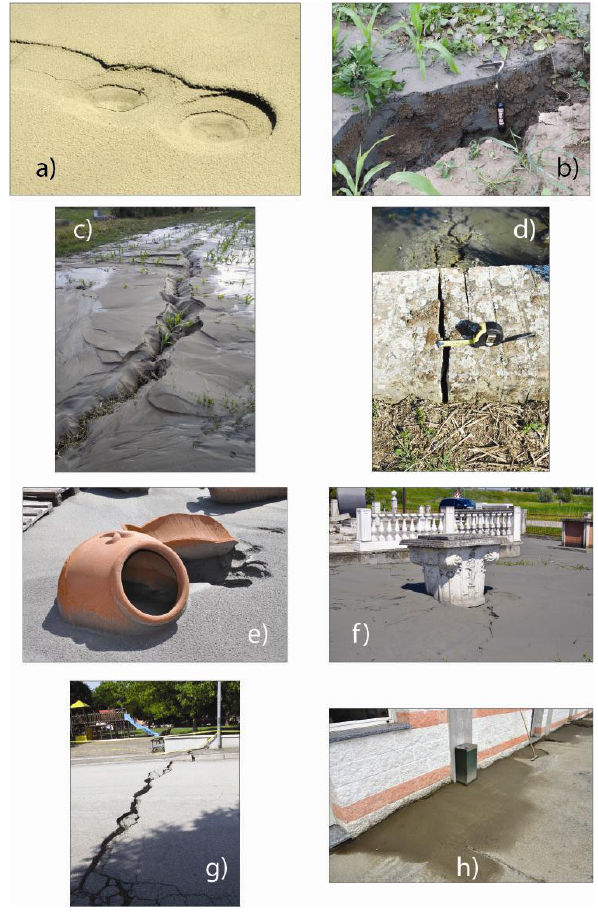
635 Figure 3: Examples of liquefaction produced by the 2012 Emilia sequence on the ground 636 Fig. 3. Examples of surface phenomena produced by the 2012 and on manmade structures: a) detail of aligned multiple sand blows nearby 637 Emilia sequence on the ground and on manmade structures: (a) detail of aligned multiple sand blows nearby Sant’Agostino; (b) ∼ 20cm-wide open fracture with liquefaction near San Carlo. It is possible to observe several cm-wide, grey sand-filled cracks that represent the path to the surface of the liquefied material; (c) 30m- long open fracture with massive ejection of dark grey sand in San Carlo (photo by L. Ghidoni); (d) fracture affecting the bridge over a channel filled with liquefied sand near Burana; (e) the warehouse of this pottery shop in San Carlo was covered by a ∼ 15cm-thick layer of liquefied sands and silts; (f) liquefied sand filled this water well and poured out to cover a ∼ 500m 2 circular area; (g) fracture affecting a paved road in San Carlo; (h) the ground/building limit often represented a preferential way of outflow for liquefaction, like in this case at San Felice sul